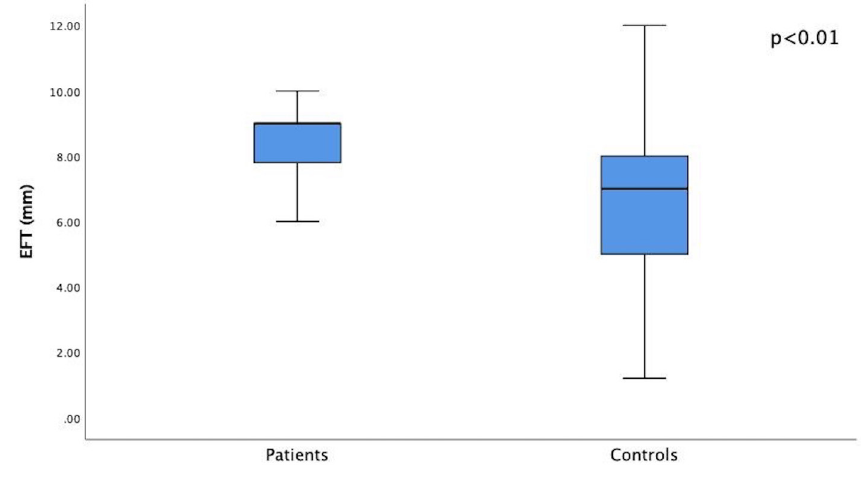
Figure 4. Aortic velocity propagation (AVP) values between study groups. (AVP:28.2±16.0 cm/s vs 58.1±17.5 cm/s p<0.01). p value was calculated by the student’s t test. p<0.05 was considered statistically significant.